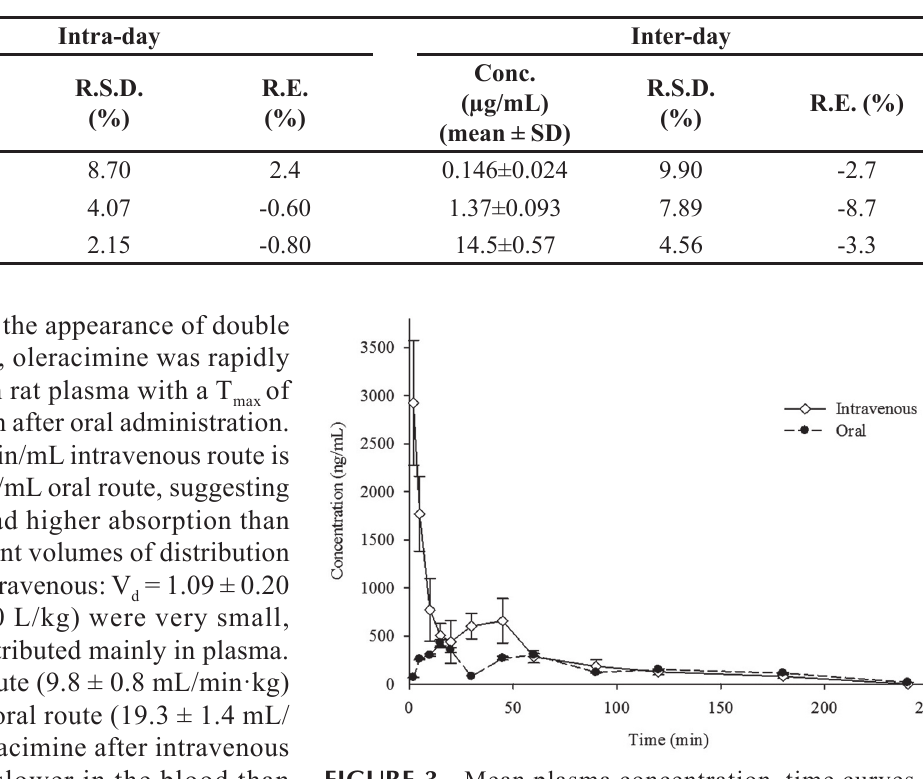
TABLE I - Precisions and accuracies of oleracimine in rat plasma (intra-day: n = 5; inter-day: n = 3 days with 5 replicates per day)